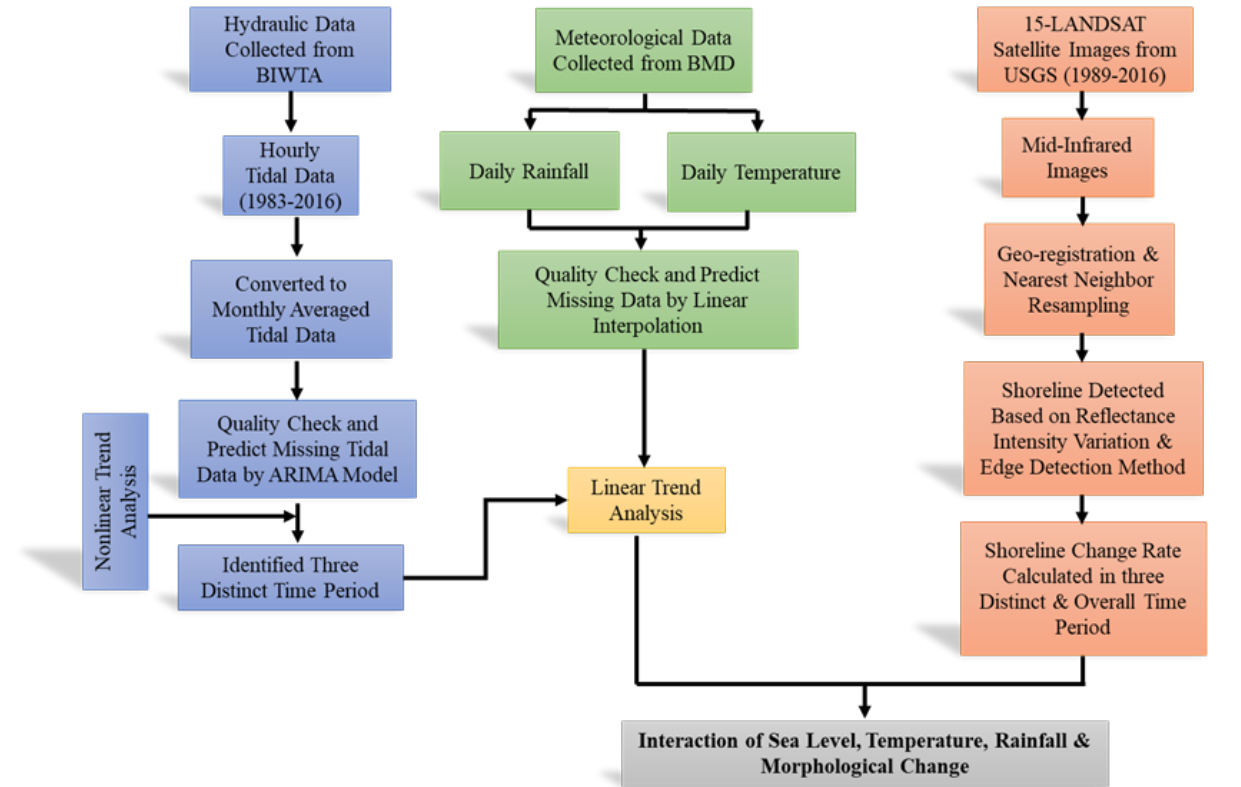
Figure 3. Flowchart used for evaluating sea level and morphological changes in this study.